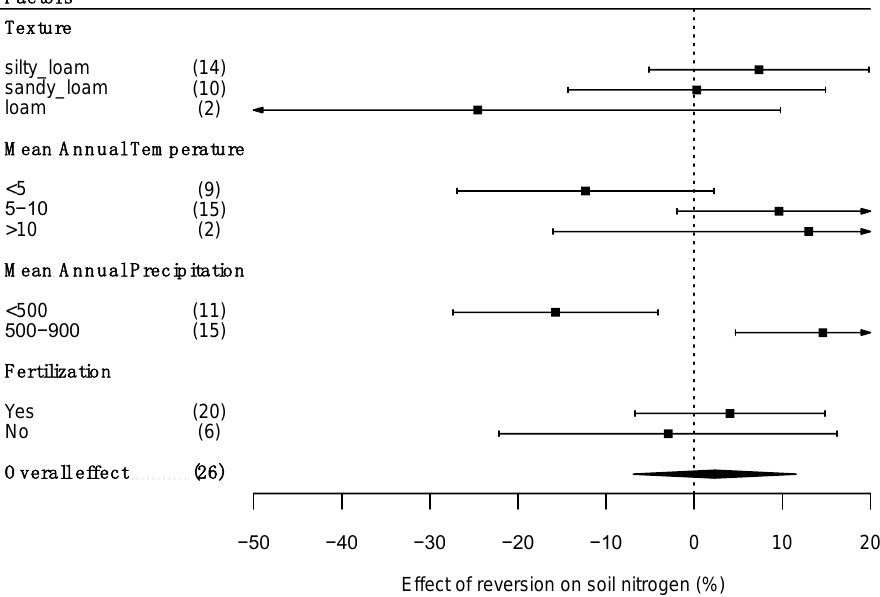
Figure 5. Percentage change of nitrogen stocks (Mg N ha − 1 ) after the reversion of perennial crops according to soil texture, mean annual temperature ( ◦ C), mean annual precipitation (mm), fertilization. Error bars represent the 95% confidence intervals. Parenthesis indicates the number of observations used to calculate the effect size.